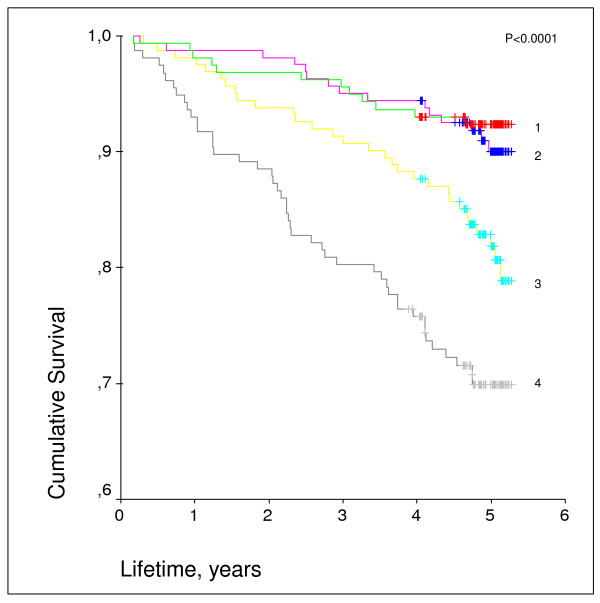
Kaplan-Meier-curves of the unadjusted cumulative overall survival according to increasing quartiles of YKL-40 at baseline (59.5 ng/ml). Curves presented from top: The mortality rate was 1) 7.6% for first quartile values of YKL-40 (≤ 39 ng/l); 2) 9.3% for second quartile values of YKL-40 (39.1-59.5 ng/l); 3) 18.5 % for third quartile values of YKL-40 (59.6-111 ng/l), and 4) 29.3 % for four quartile values of YK-40 (> 111 ng/l), p < 0.0001. Y-axis represents the lifetime of the participants during the 5 years follow-up period.